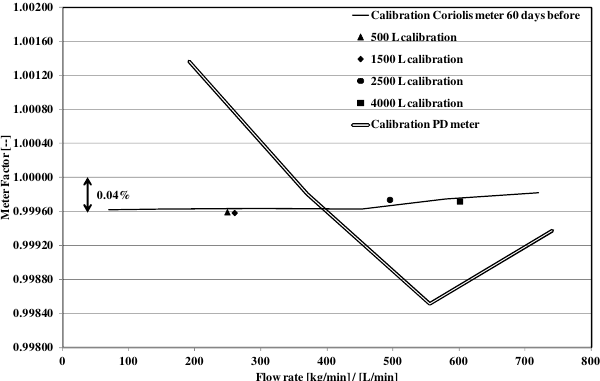
Fig. 5. Meter factors curve of Coriolis mass flow meter and PD meter. Meter factor calibration points of Coriolis mass flow meter during proving tank calibration. Note: the four points shown in Figure 5 (500 L calibration, 1500 L calibration, 2500 L calibration and 4000 L calibration) are the found meter factors for the mass reading of the Coriolis mass flow meter. They show small deviations from the original meter factor curve of the Coriolis mass flow